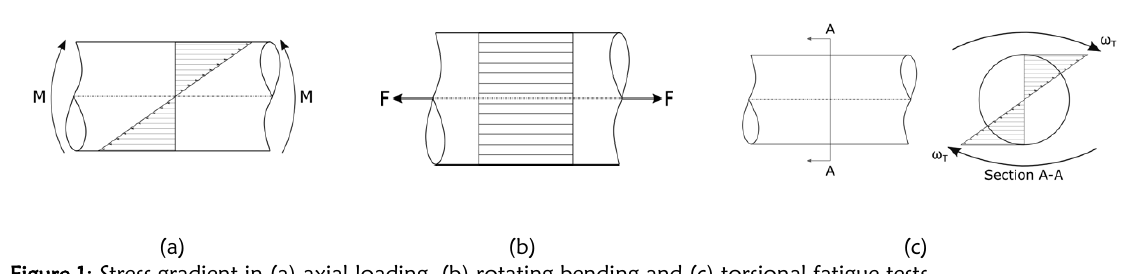
Figure 1: Stress gradient in (a) axial loading, (b) rotating bending and (c) torsional fatigue